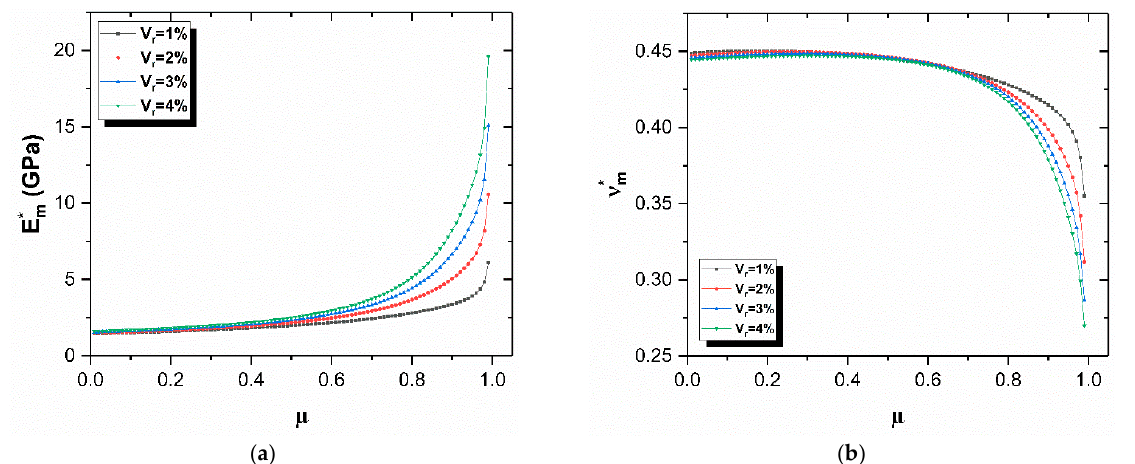
Figure 13. Effective elastic moduli of composite reinforced by randomly CNT inclusion in PP matrix,